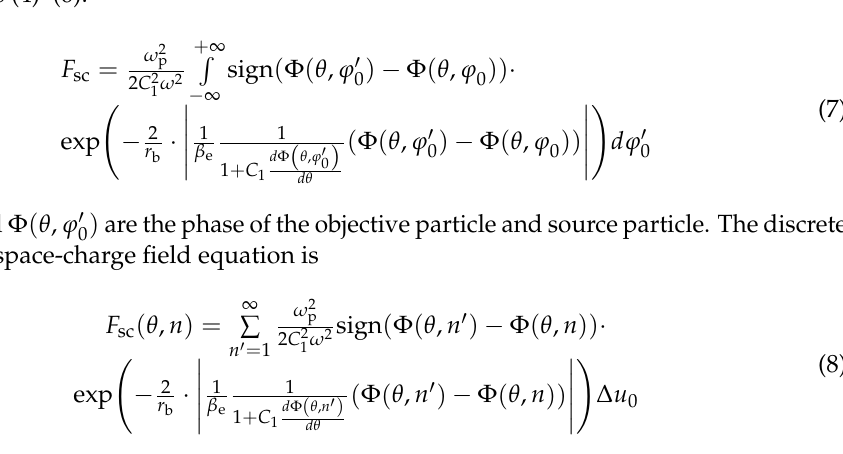
Figure 4. The source particles chosen from periodic extended particles, whose phase difference with the objective particle is at      , .